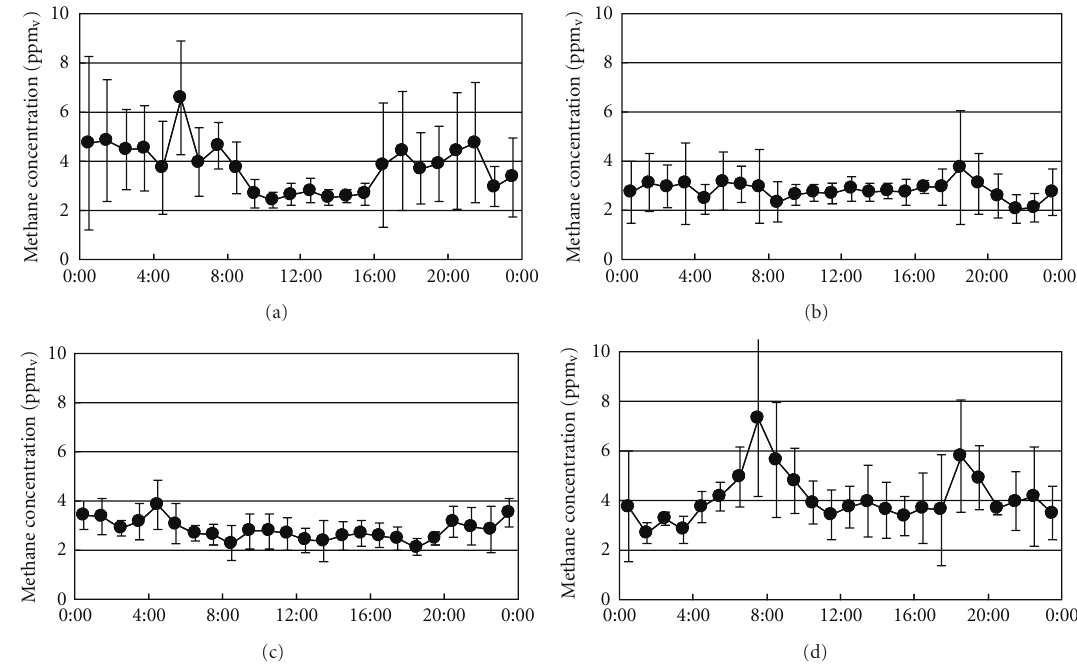
Figure 2: Hourly mean methane concentrations at 2.4m during winter (a), spring (b), summer (c), and fall (d) measurement periods. Bars indicate the range of concentration within ± standard